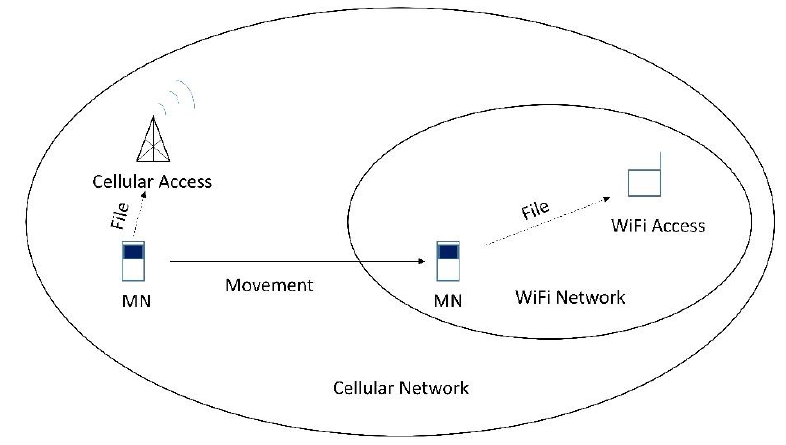
Figure 1. Basic WiFi offloading scenario